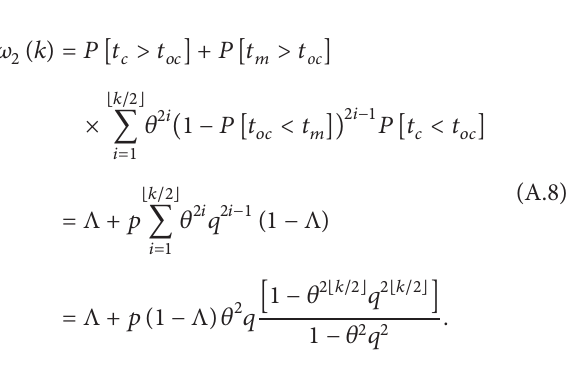
number of movements, with no registration and no